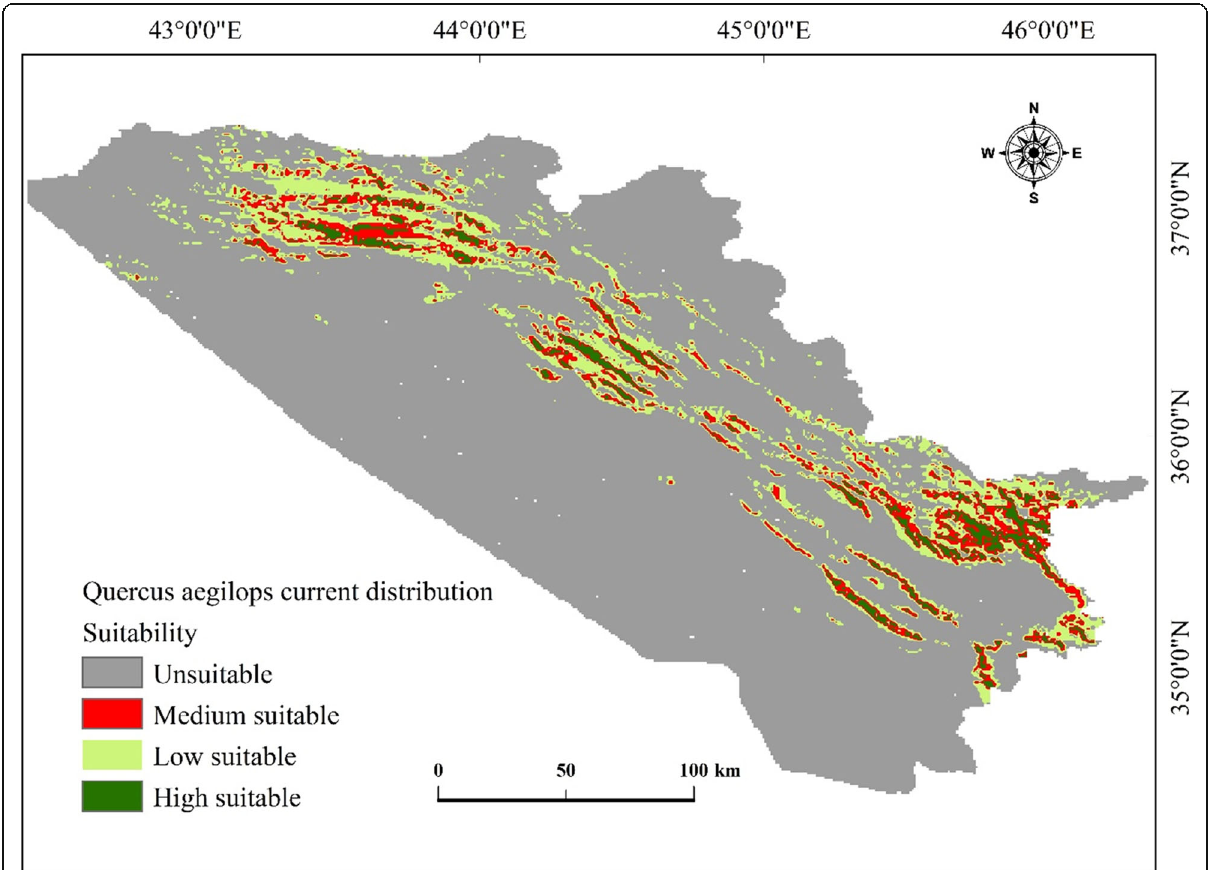
Fig. 2 Current habitat suitability distribution of Q. aegilops modeled using the selected environmental predictors and presence